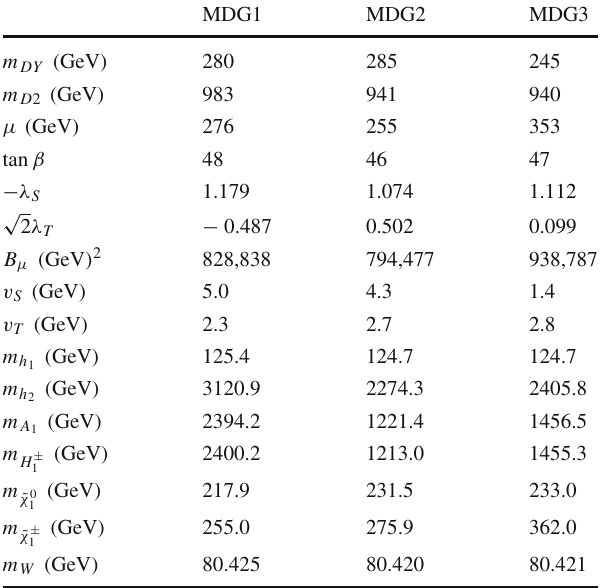
Table 1 Benchmark points for the MDGSSM. Input parameters are given above the double line, and masses of the most important particles below MDG1 MDG2